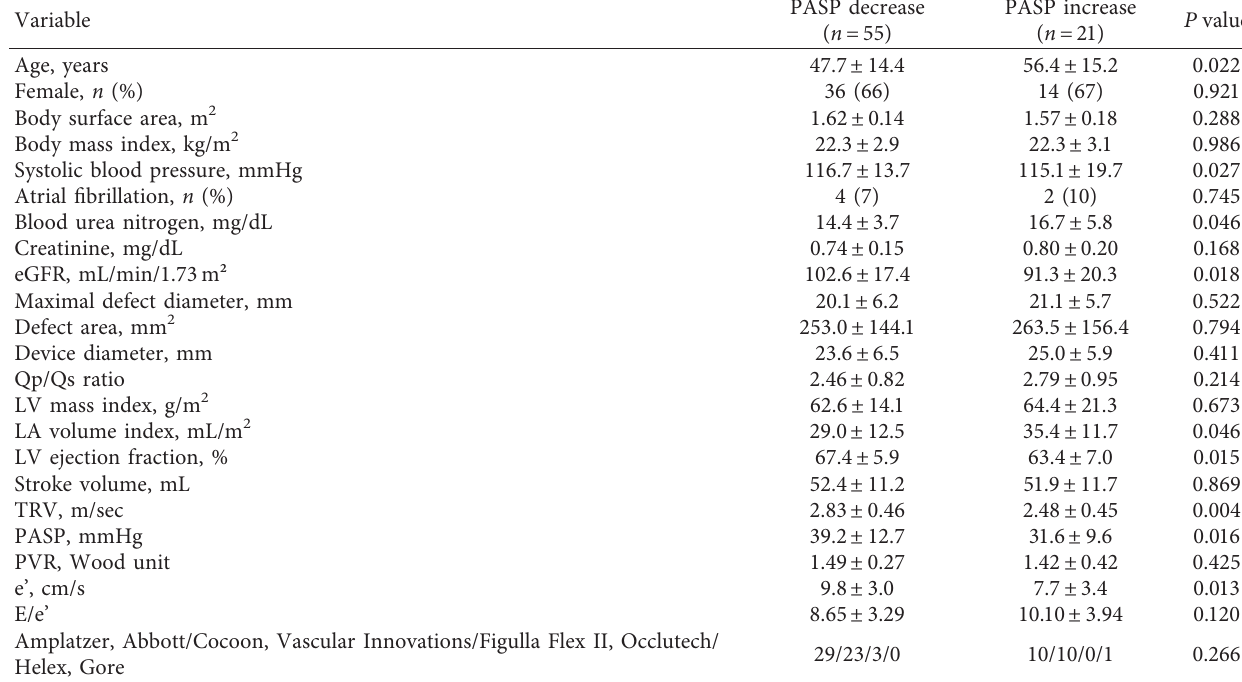
Table 4: Comparison between patients with increased PASP and decreased PASP immediately after device closure of ASDs ∗ . Variable